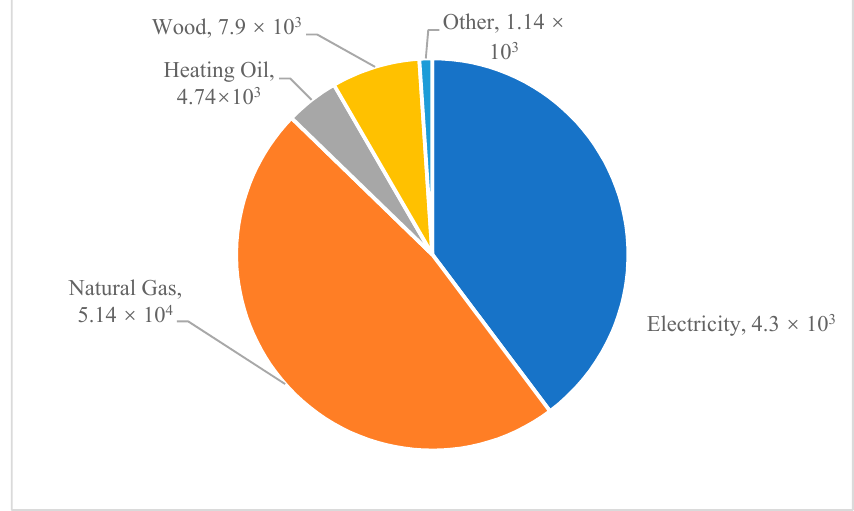
Figure 3. Average household annual energy usage for 2009 in kJ per year [23].